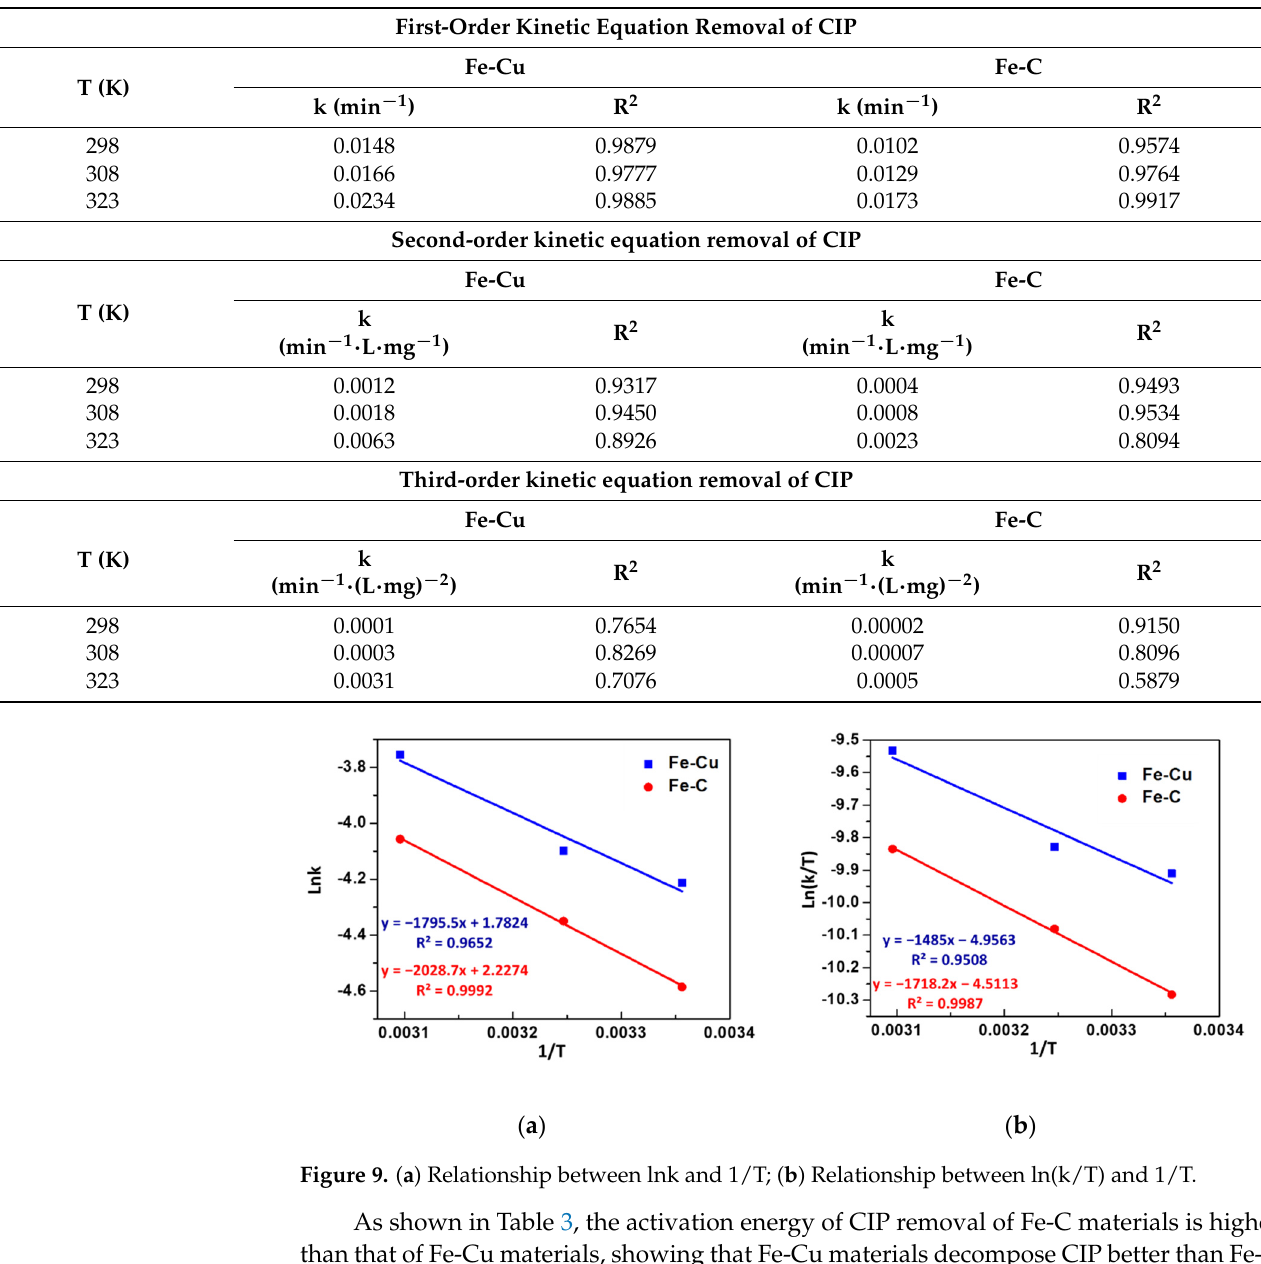
Table 2. The calculation results of first-order, second-order and third-order CIP removal reaction rate constants and linear regression coefficients of Fe-Cu and Fe-C materials at different temperatures.